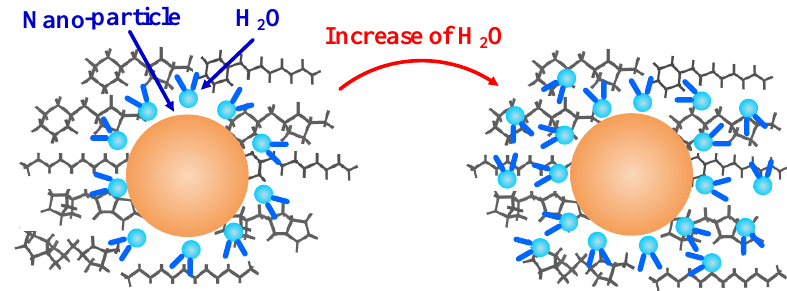
Figure 6. The adsorption of water molecules by nano-particles.